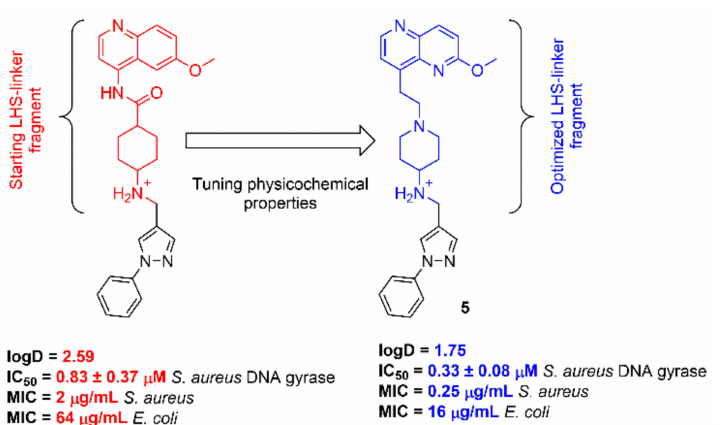
Figure 2. The impact of lipophilicity (logD) and structural flexibility on the change in IC 50 for a com- pound containing methoxy-quinoline cyclohexyl-amide LHS-linker combination against S. aureus DNA gyrase from our previous study ( left ) [18] and compound 5 ( right ) comprising naphthyri- dine aminopiperidine LHS-linker construct confirming the rationally optimized physicochemical properties and reduced rigidity (amide vs. ethylene) leading to the improved potency and antibacte- rial activity. Table 1. DNA supercoiling inhibition of S. aureus and E. coli DNA gyrase and topoisomerase IV and decatenation activity of human topoisomerase II α affected by NBTIs.